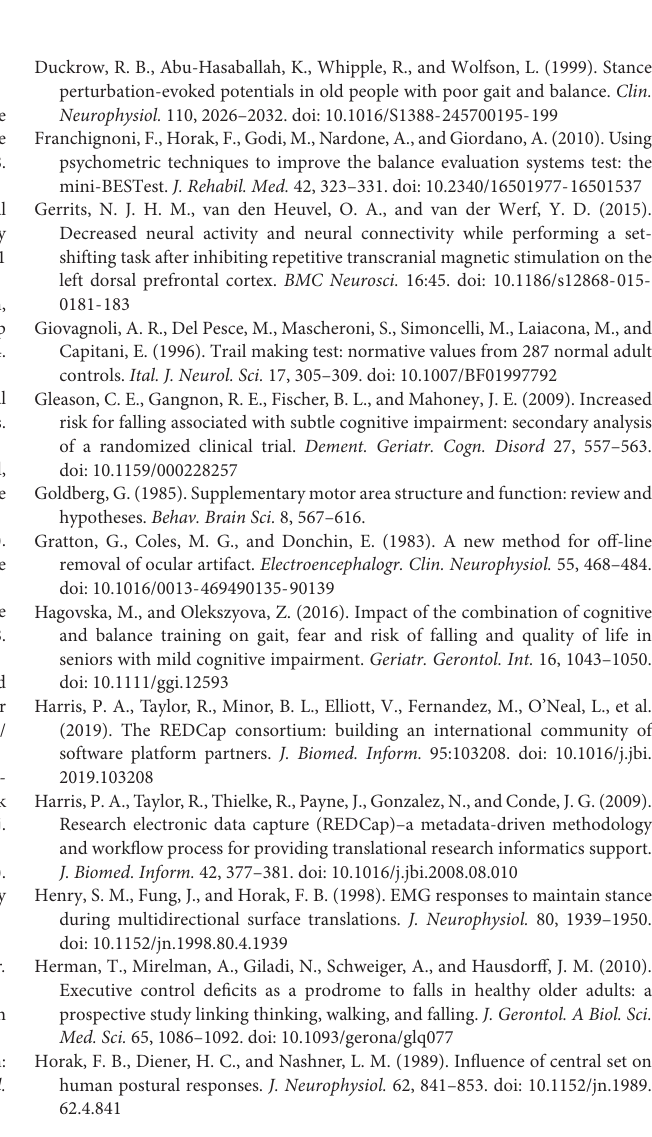
Supplementary Figure 1 | No significant associations were observed between clinical balance ability and directional specificity of muscle activity. Condition-averaged muscle activity is shown for (A) soleus and (B) tibialis anterior muscles for example participants with higher or lower directional specificity scores. Muscle activity evoked by forward movements of the floor (resulting in backward leaning posture) is represented in magentas and activity evoked by backward movements of the floor is represented in blues, with darker colors for larger perturbations. Antagonist activity (i.e., soleus activity in forward perturbations and tibialis anterior activity in backward perturbations) is shaded for clarity. Vertical lines at 100 ms, 200 ms, and 300 ms mark the bounds of the time bins of interest. The later (200–300 ms) time bin is shaded in all panels. Directional specificity is plotted against miniBESTest scores for the (C) soleus muscle and (D) tibialis anterior muscle in each perturbation magnitude for early (100–200 ms) and late (200–300 ms) time bins. Supplementary Figure 2 | Perturbation-evoked cortical N1 responses were not associated with clinical balance ability. Cortical N1 response amplitudes are plotted against miniBESTest scores in each of the perturbation conditions. Forward movements of the floor (resulting in backward leaning posture) are represented in magentas and backward movements of the floor are represented in blues, with darker colors for larger